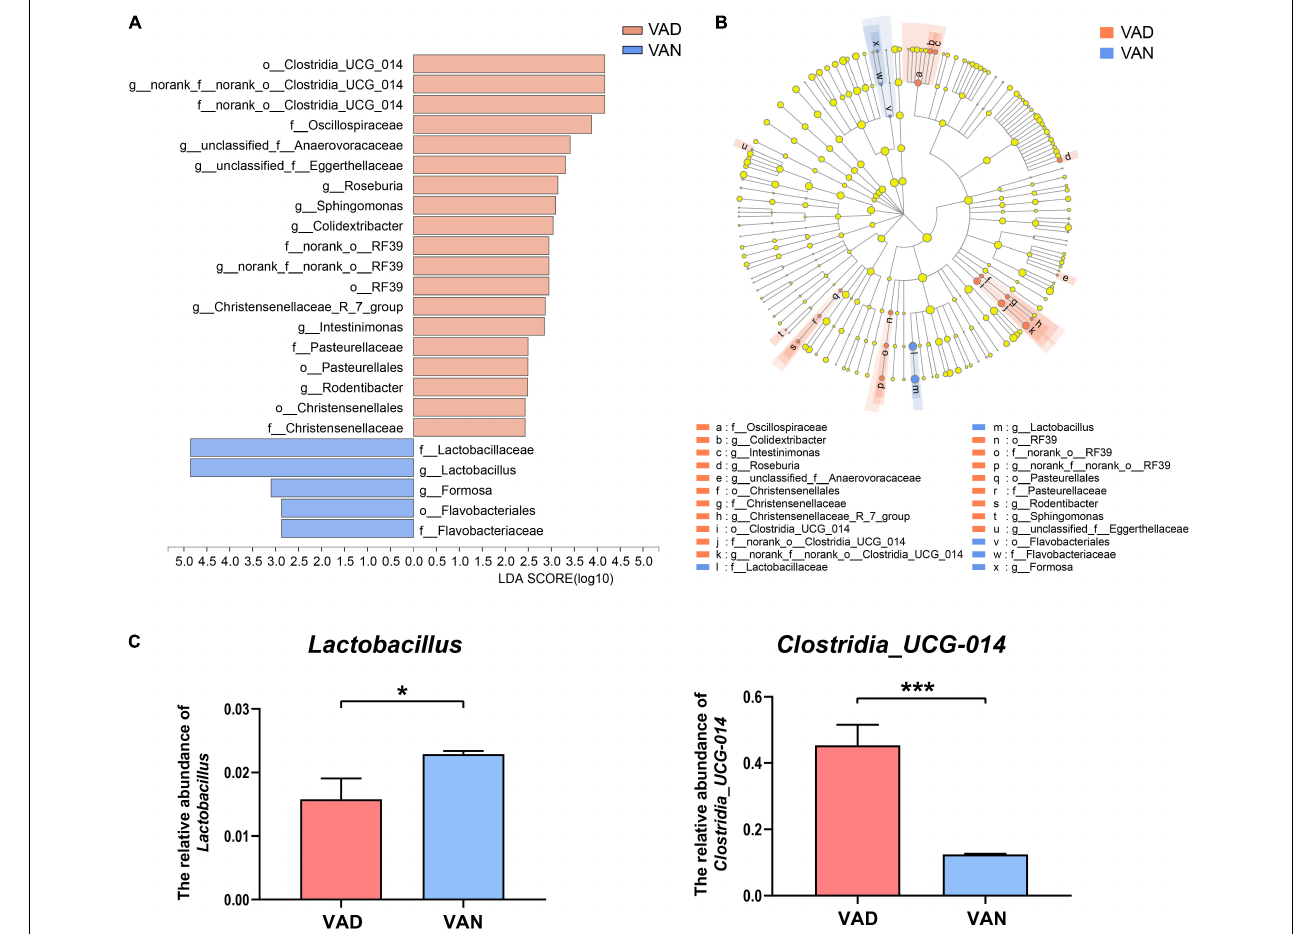
FIGURE 7 | Linear discriminant analysis (LDA) effect size (LEfSe) analysis of the 16S rRNA gene sequencing data and the RT-qPCR verified abundance of Lactobacillus and Clostridia_UCG-014 . (A) Histogram of the LDA scores computed for differentially abundant bacterial taxa between the VAD and VAN groups. Only taxa with a LDA score (log 10 ) > 2 and P < 0.05 are listed. (B) Cladogram showing the impact of the diet on the taxonomic distribution of the bacteria. A total of 23 differentially abundant bacterial taxa were detected. Of those, seven bacterial taxa were significantly overrepresented in the VAN group (blue) and 15 bacterial taxa were overrepresented in the VAD group (red). (C) The RT-qPCR validation of the changes in the relative abundance of Lactobacillus and Clostridia_UCG-014 by using their specific primers. VAD, vitamin A deficiency diet; VAN, vitamin A normal diet. n = 10 per group. ∗ P < 0.05, and ∗∗∗ P <